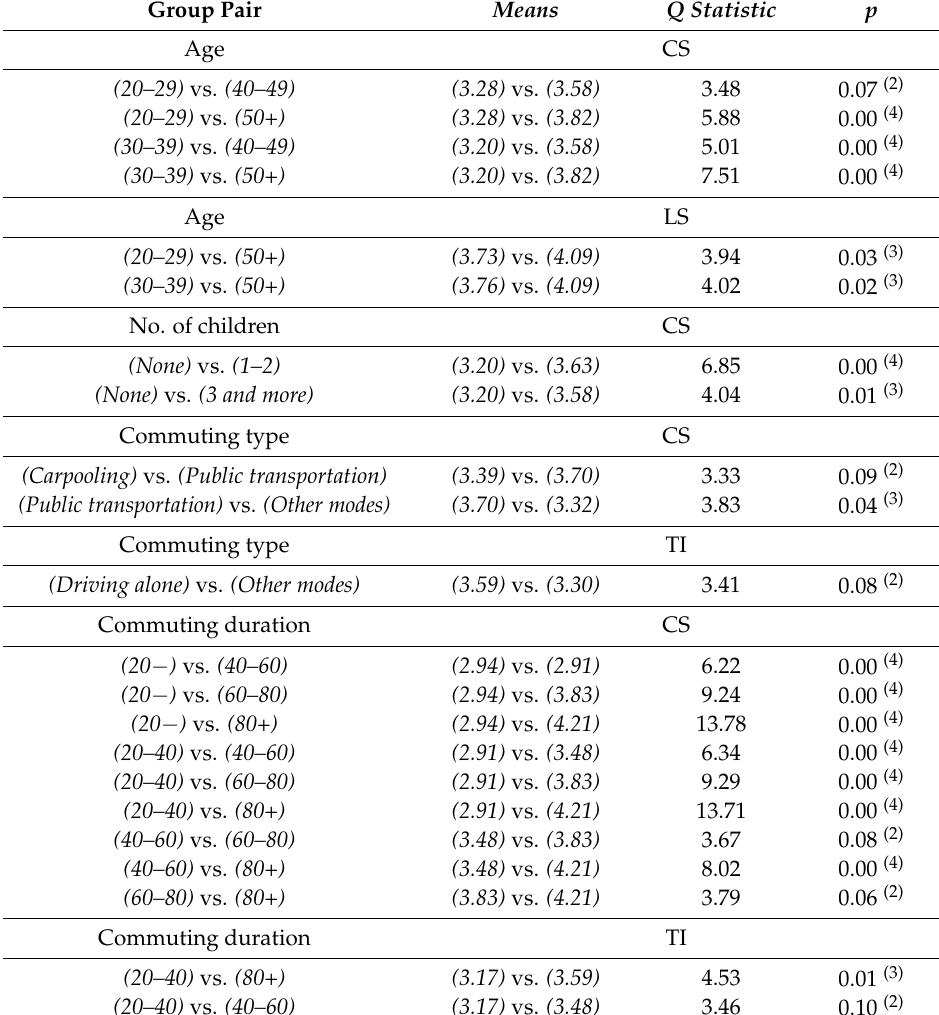
Table 10. Tukey HSD (honestly significant difference) test results (1) . (CS: Commuting stress, LS: Life satisfaction, TI: Turnover